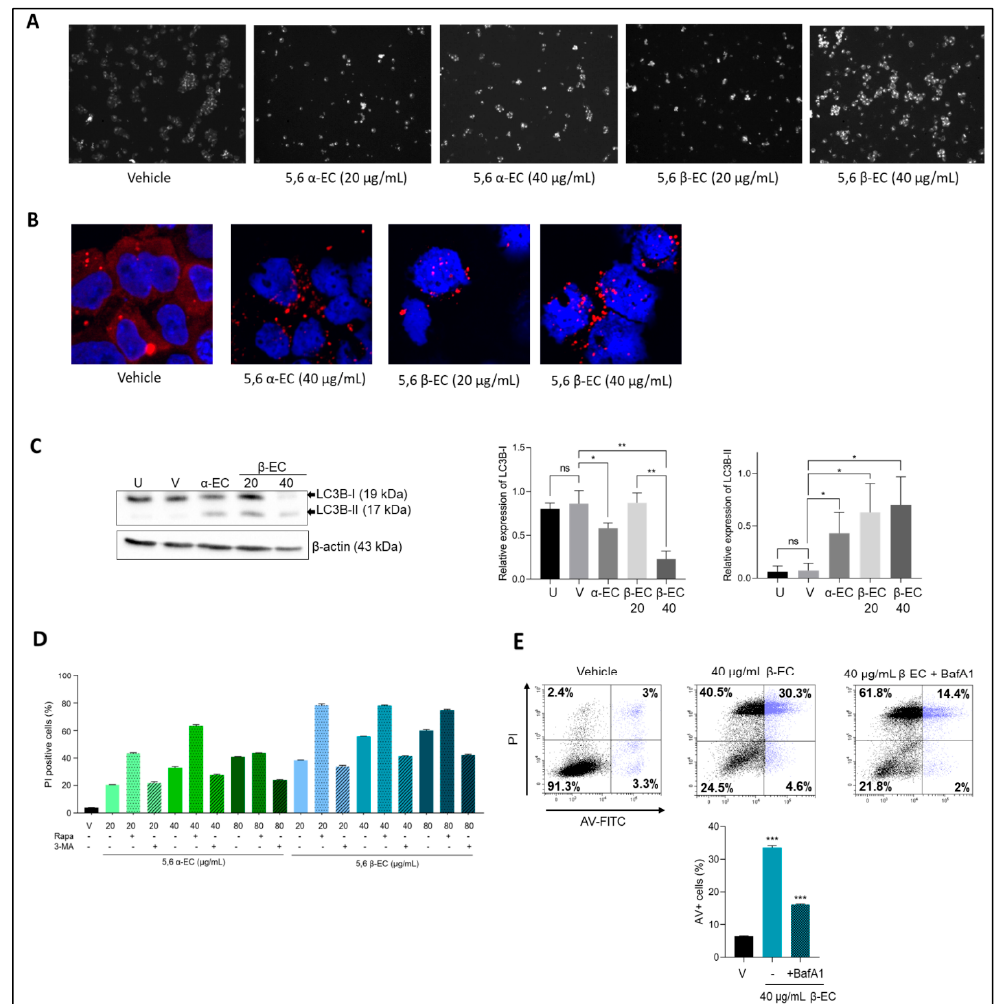
Figure 5 . 5,6-ECs induce an autophagy-mediated cell death. ( A ) U266 cells were treated with vehicle or 5,6 α / β -EC (20, 40 µg/mL) for 20 h. Cells were then stained with an autophagosome specific fluorescent probe and analyzed with an Olympus BX53 fluores- cent microscope (× 40, magnification) ( B ) p62 expression was analyzed by IF in EtOH- and 5,6-ECs-treated cells. We used a pri- mary Ab against p62, and a goat Alexa Fluor 488-conjugated anti-rabbit IgG as secondary Ab. Slides were counterstained with DAPI and analyzed with a confocal microscope (Fluoview FV100, Olympus,CA) (× 180, magnification). ( C ) U266 cells were un- treated (U), vehicle-treated (E) or with 5,6 α -EC (40 µg/mL) or 5,6 β -EC (20 or 40 µg/mL). Within 24 h, whole-cell proteins were extracted, separated by SDS-PAGE, and transferred onto membranes then incubated with anti-LC3B or anti- β -actin (as a control) antibodies. Protein levels were estimated by densitometry and collected data from three independent experiments were presented in histograms (means ± SD). ( D ). The modification of autophagic flux was evaluated by flow cytometry. U266 cells were seeded into 24-well plates for 24 h. The cells were treated with 5,6 α -EC or 5,6 β -EC alone or in combination with 5 µM rapamycin or 10 µM 3-MA for 24 h. The cells were stained with PI and PI positive cells were recorded. At least 10 4 events were gated. The experi- ment has been done once with triplicate samples. ( E ) U266 cells were pre-treated with BafA1 (50 nM) for 4 h and then treated with 5,6 β -EC (40 µg/mL). The cells were stained with annexin V/IP as described before and sorted. Cytometry profiles were presented together with the percentage of cells within each quadrant. The percentage of annexin V+ cells in each culture condition is pre- sented in the histogram. * p <0.05; ** p < 0.01; *** p < 0.001; ns, not significant with the t -test.